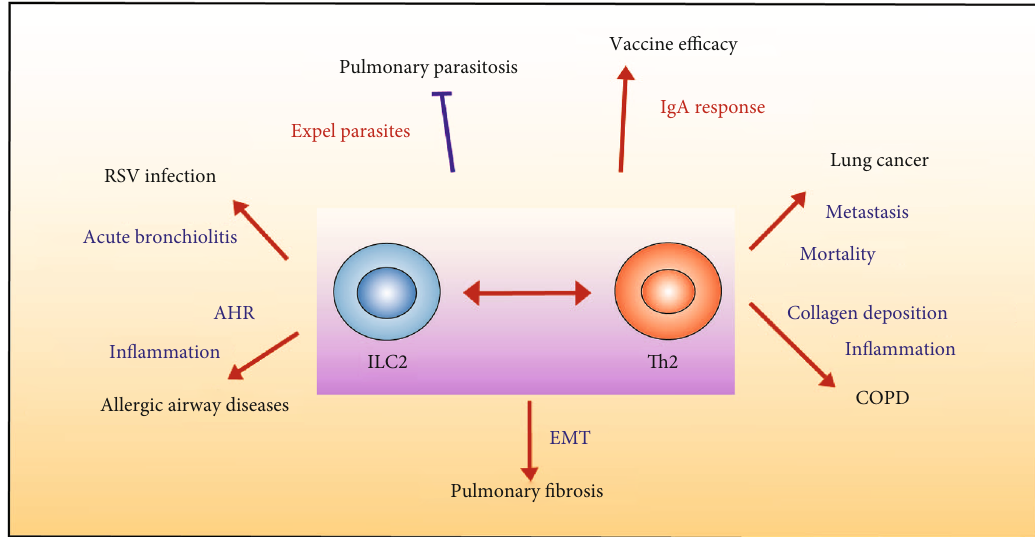
Figure 3: The relevance of ILC2s and Th2 cells crosstalk in lung